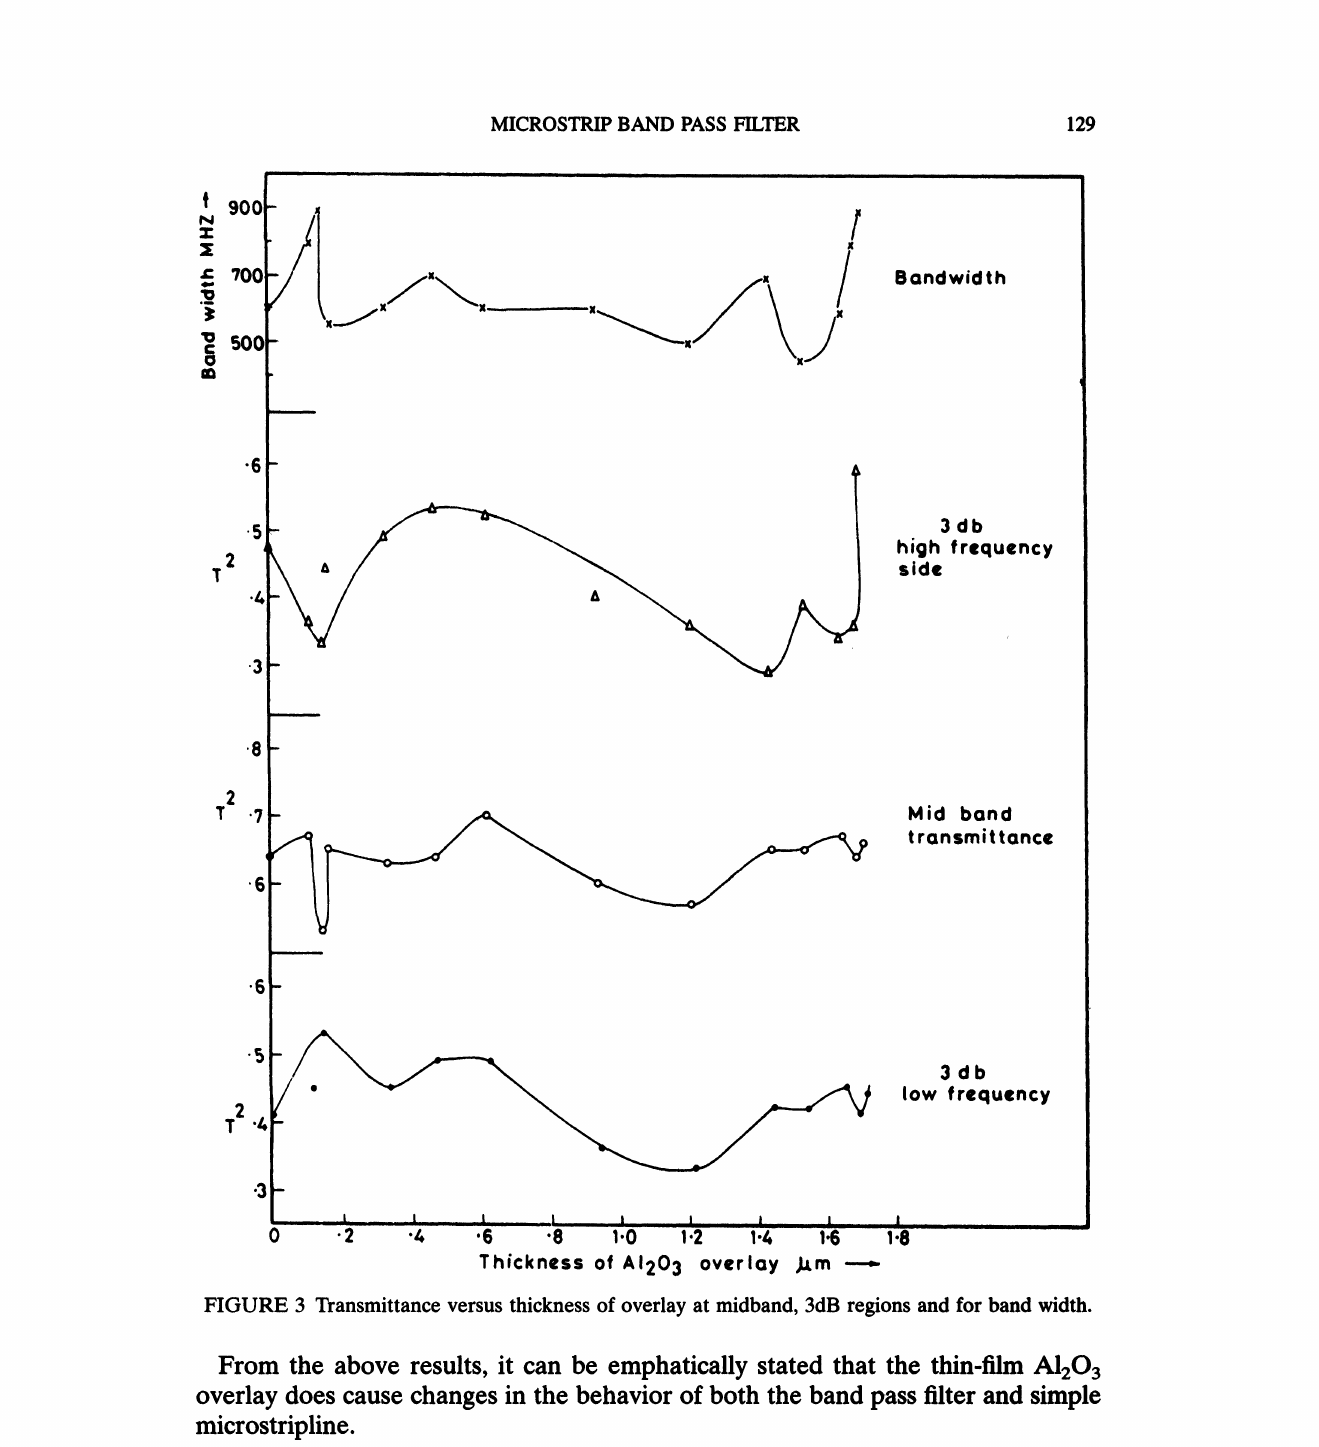
FIGURE 3 Transmittance versus thickness of overlay at midband, 3dB regions and for band